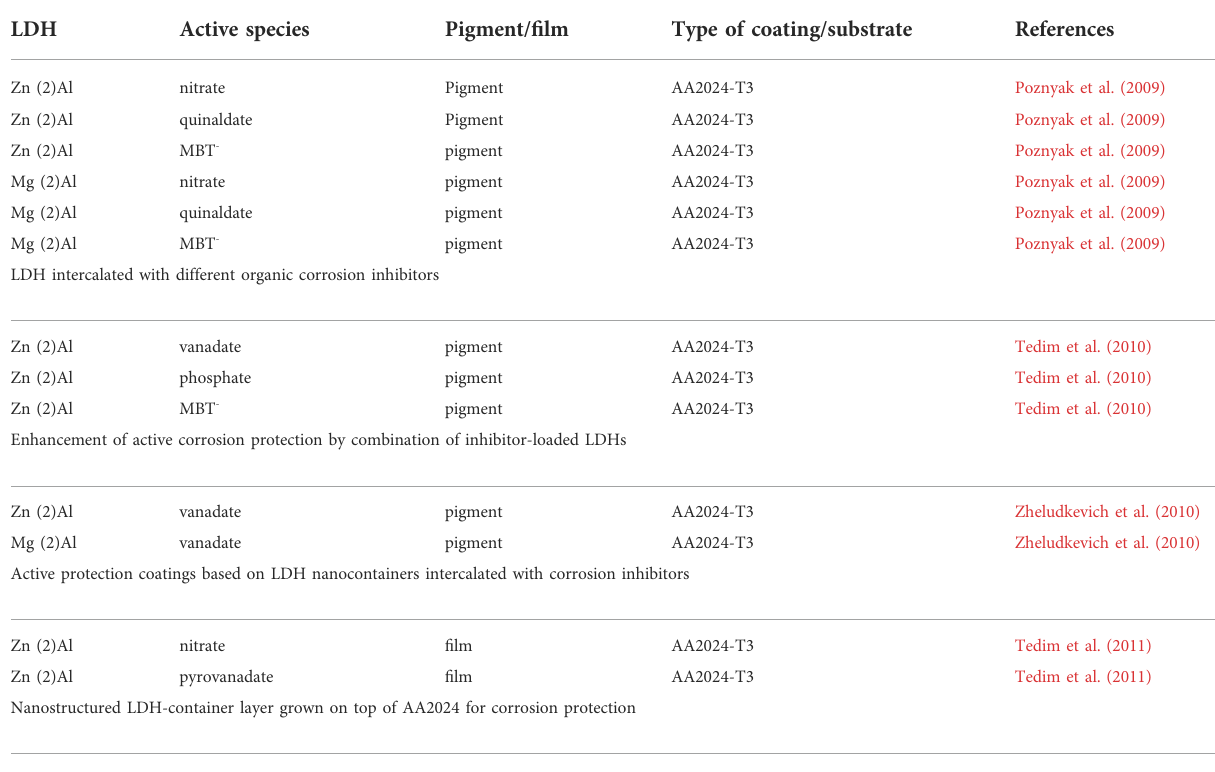
TABLE 1 Overview of CICECO ’ s functional LDH for corrosion-related